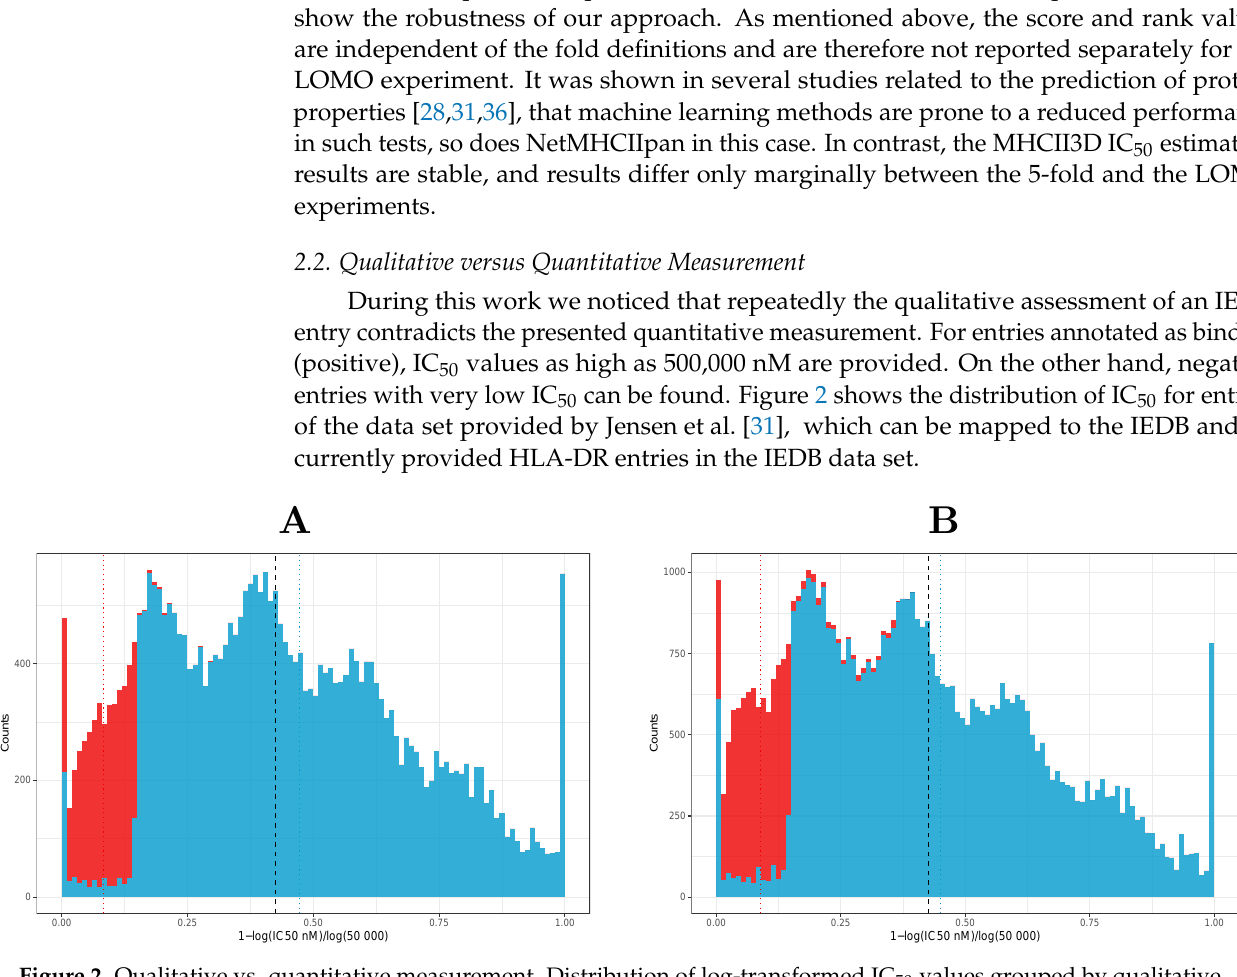
Figure 2. Qualitative vs. quantitative measurement. Distribution of log-transformed IC 50 values grouped by qualitative measurement. Data are shown for ( A ) those entries of the data set provided by Jensen et al. [31], which can be mapped to the IEDB, and ( B ) the complete IEDB data set (HLA-DRB entries). IC 50 values were transformed as described by Jensen et al. (1 − log ( IC 50 ) / log ( 50,000)); therefore IC 50 values > 50,000 nM were set to 50,000 nM beforehand. Entries defined as binders (Positive, Positive-Low, Positive-Intermediate, Positive-High) are shown in blue, non-binder (Negative) are shown in red. Mean values are indicated as dotted lines; the black dashed lines indicate IC 50 =